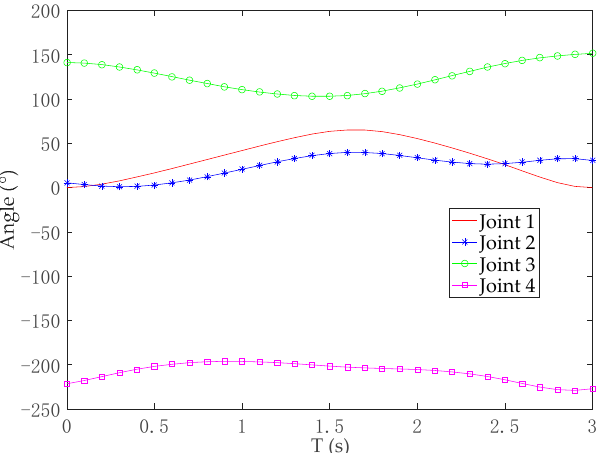
Figure 7. The end motion trajectory of the robot in the case of Equation (43).